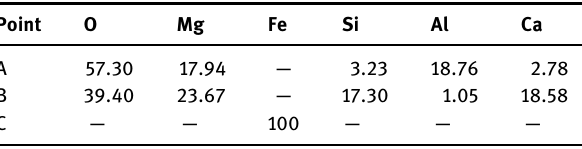
Table 8: Composition of crucible ( wt% ) at selected